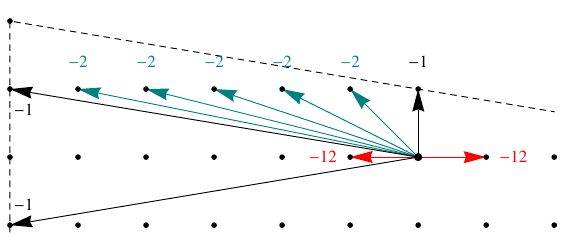
Figure 4 . Part of the ray structure of the toric base ~ B for the mirror ~ X of the generic elliptic (cid:12)bration over the Hirzebruch surface F 6